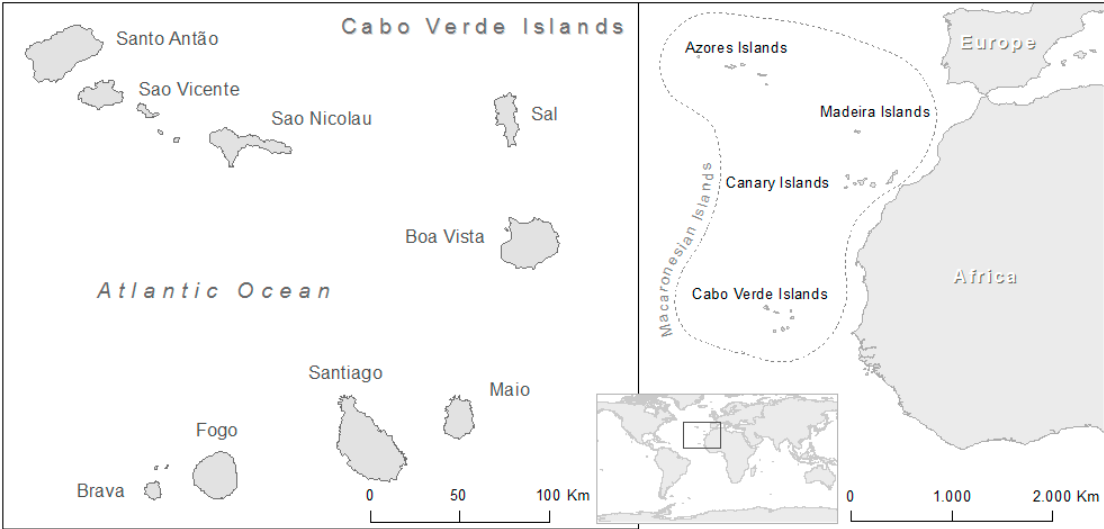
Figure 1. Cabo Verde location, with details of the Macaronesian Region.